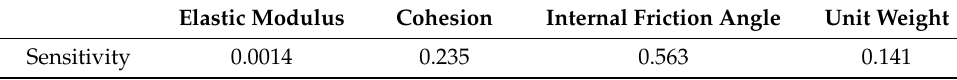
Table 14. Sensitivity analysis results of material